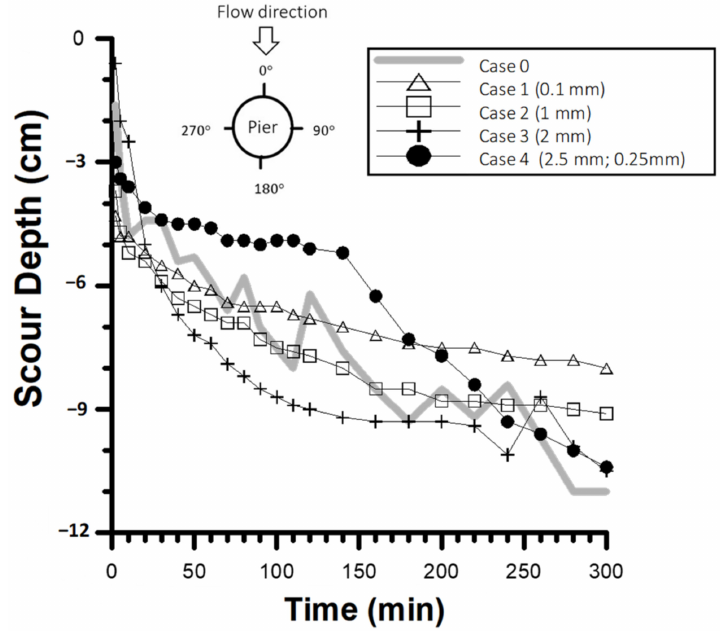
Figure 12. Developing history of scour depth at 0 ◦ of pier due to different sizes of